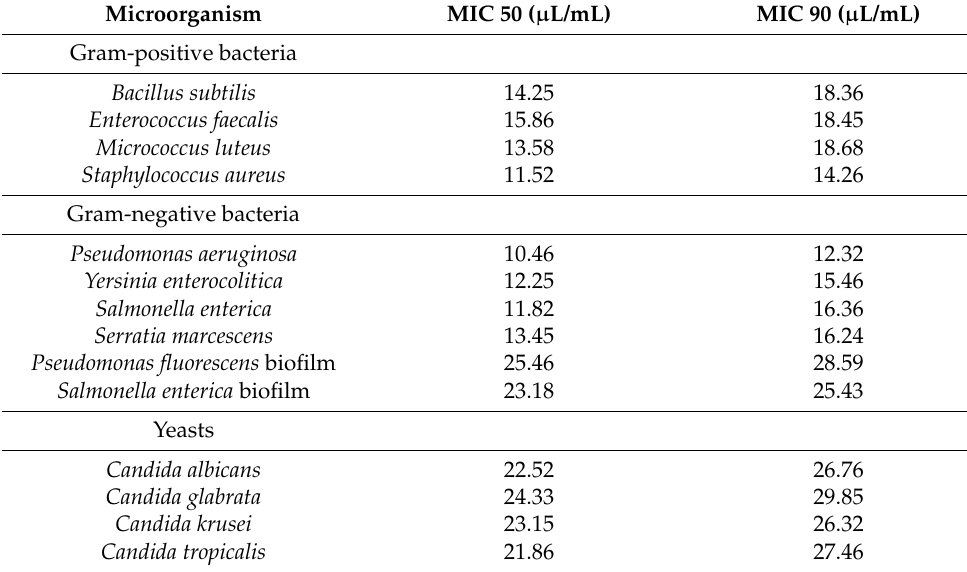
Table 3. Minimal inhibitory concentrations of